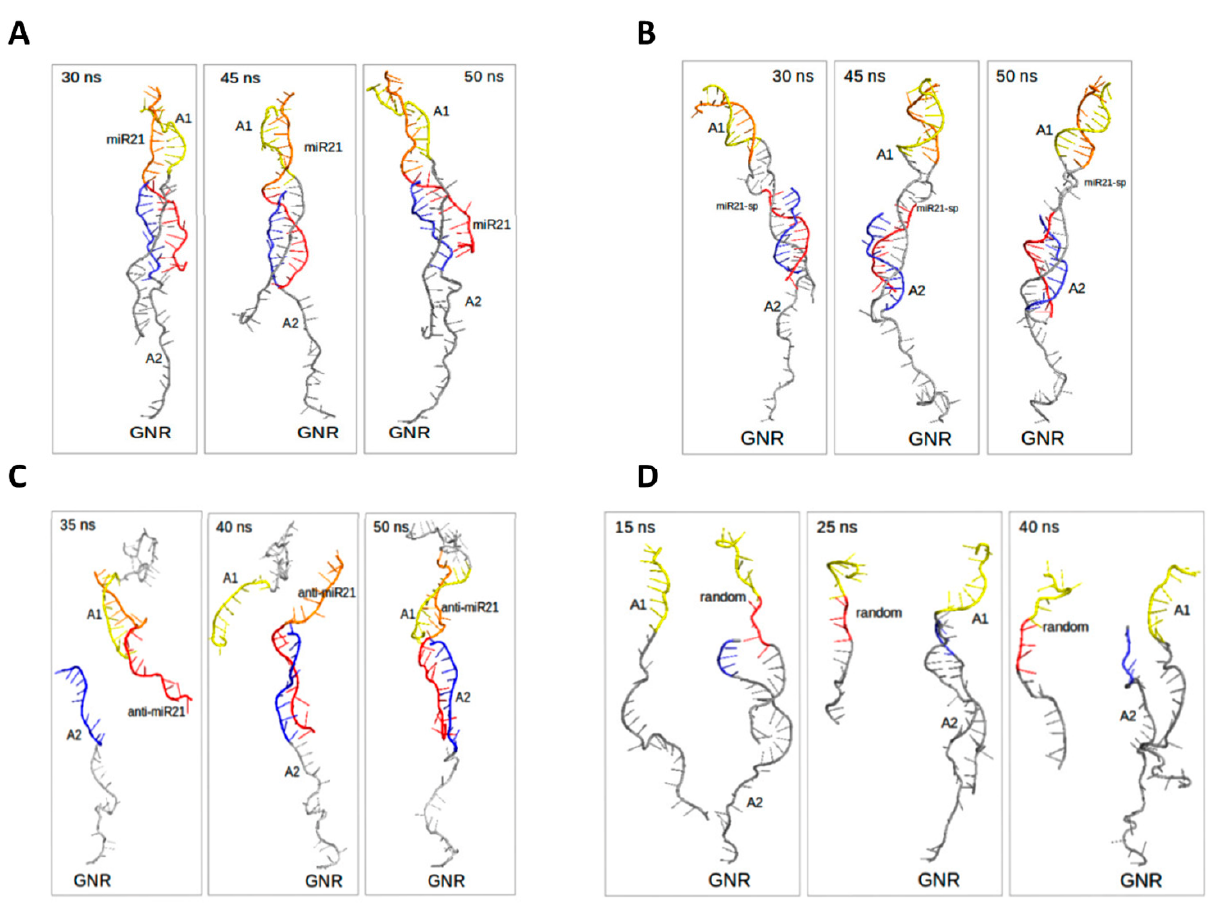
Figure 10. Resulted trajectories over 50 ns for miR21 ( A ) and miR21-sp ( B ) ternary systems and for anti-miR21 ( C ) and random ( D ) ternary systems.